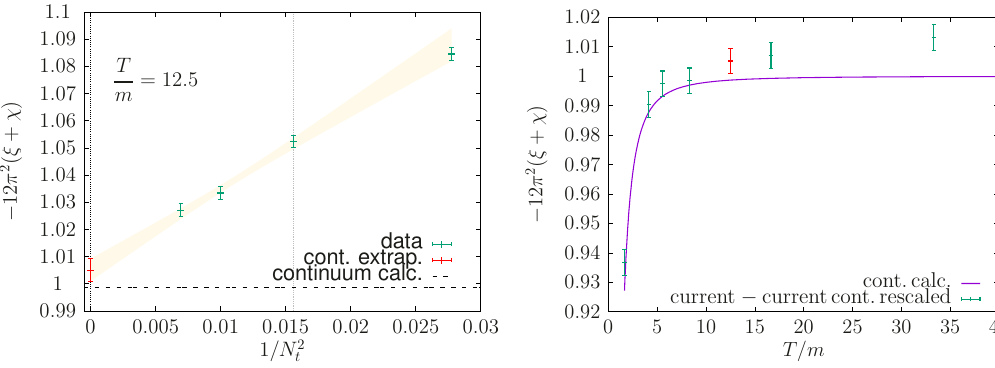
Figure 3 . Left: continuum extrapolation of ξ + χ , obtained using eq. (4.2) at T/m = 12 . 5 on LT = 4 lattices (the fit involves only the points up to the grey dotted line), compared to our analytical result from eqs. (3.14) and (3.16). Right: dependence of the numerical results obtained on 24 3 × 6 lattices (after a rescaling, see the text) on T/m , compared to the analytical